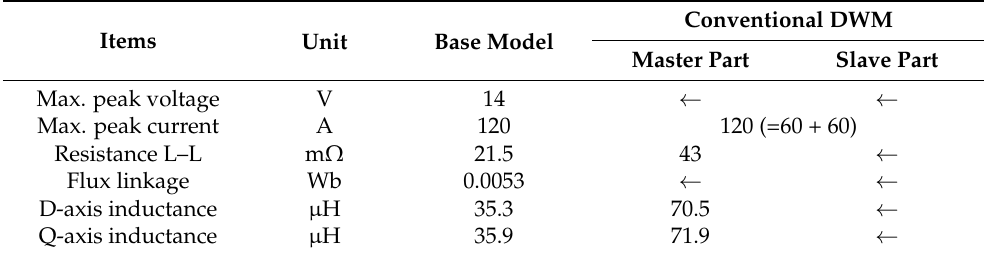
Table 2. Comparison of motor control parameters between base model and conventional DWM.